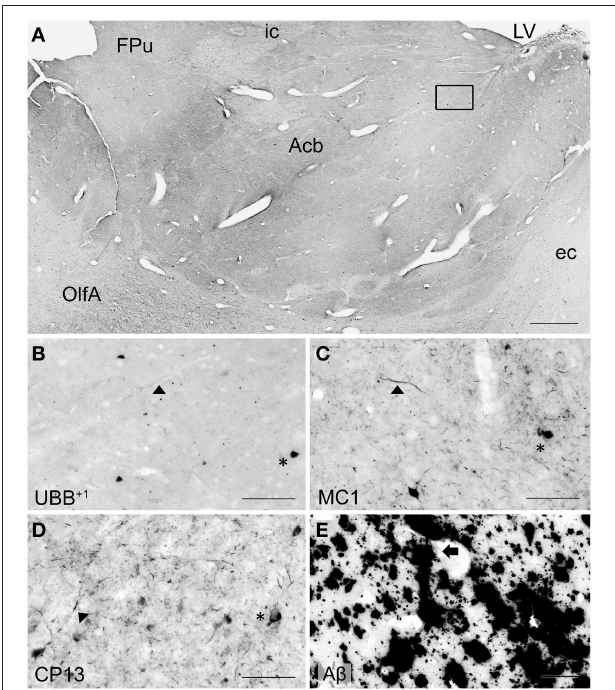
FIGURE 5 | UBB + 1 and AD neuropathology (NFTs, NTs, and A β plaques) in the human basal ganglia. (A) Photomicrograph of a 50 µ m-thick coronal section from the Acb of patient #5 (Braak 5). (B) Higher magnification of the boxed region in (A) incubated with the antibody against UBB + 1 , (C–E) Higher magnifications of boxed area in adjacent sections stained for (C) pre-tangles material (MC1), (D) tangles (CP13) and (E) A β plaques. The Acb, together with other nuclei of the basal ganglia (Cd and Pu), presents little UBB + 1 -immunoreactivity (asterisk) . Asterisks show neurons with intracellular accumulations. NTs are shown by filled triangles and A β plaques by an arrow . Bars: (A) , 1mm, (B–E) , 200 µ m. Acb, nucleus accumbens, ec, external capsule; FPu, nucleus accumbens putaminal fundus; ic, internal capsule; LV, lateral ventricle; OlfA, olfactory area.